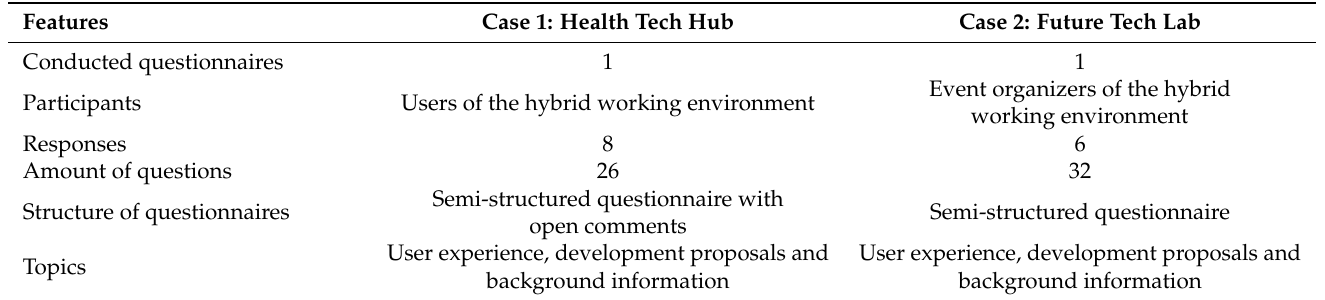
Table 4. Experience mapping